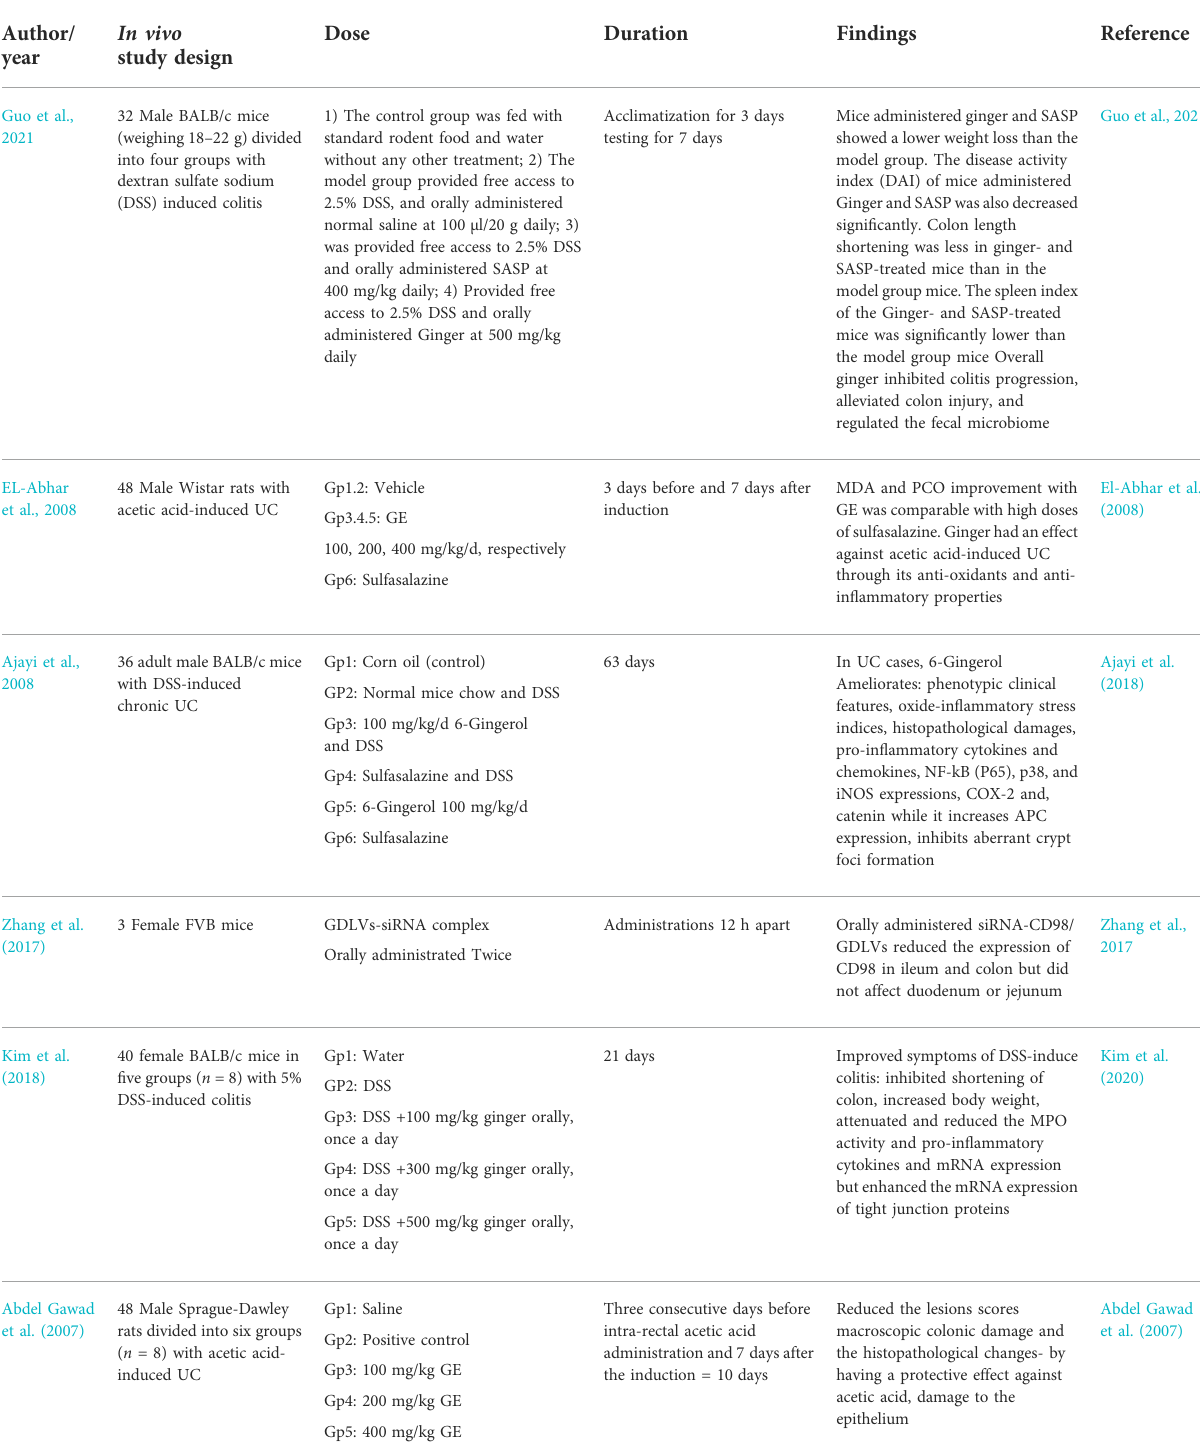
TABLE 1 The characteristics of the included in vivo studies on the effect of ginger on